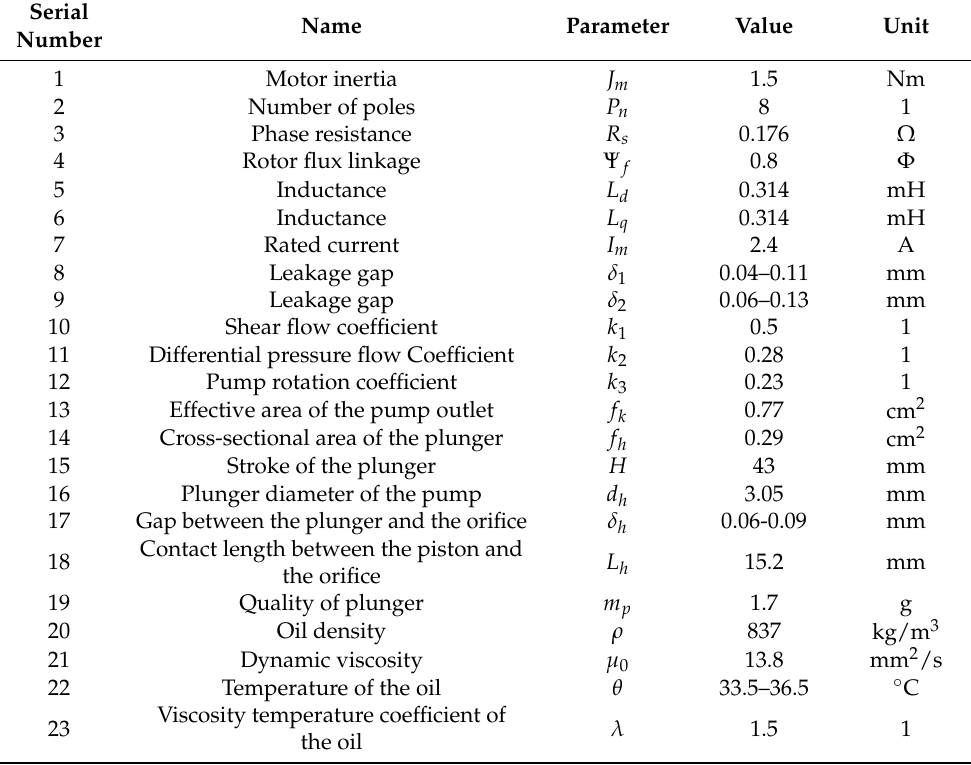
Table 1. Key physical parameters